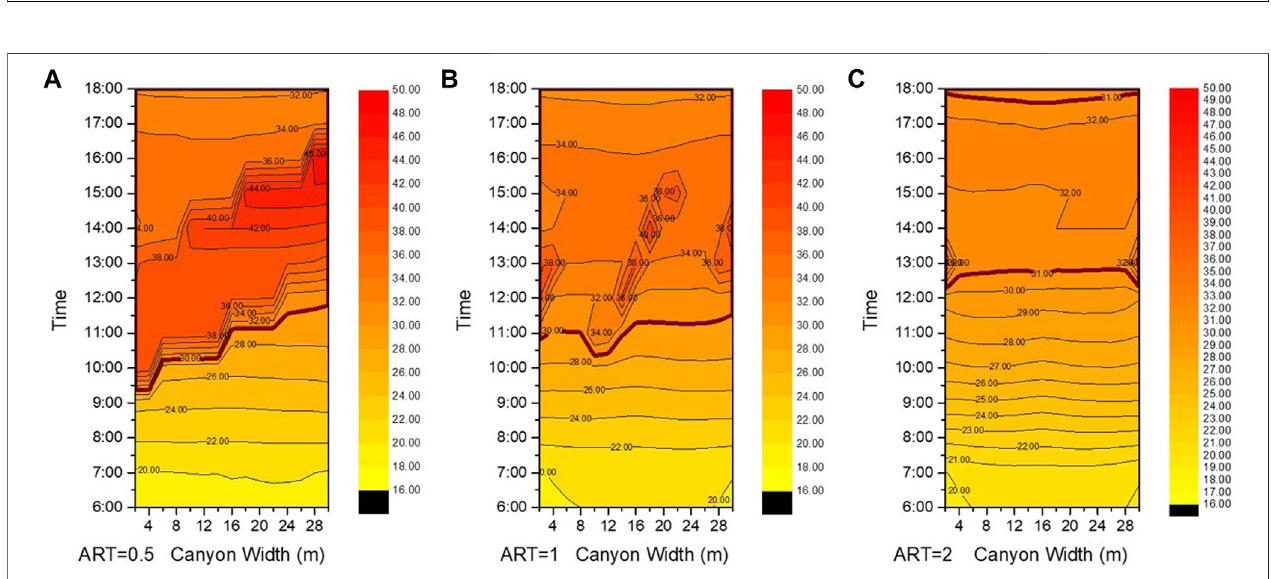
FIGURE 13 | Temporal and spacial variations in PET at the pedestrian level within the street canyons in different ART-ART = 0.5 (A) , ART = 1 (B) and ART = 2 (C) .